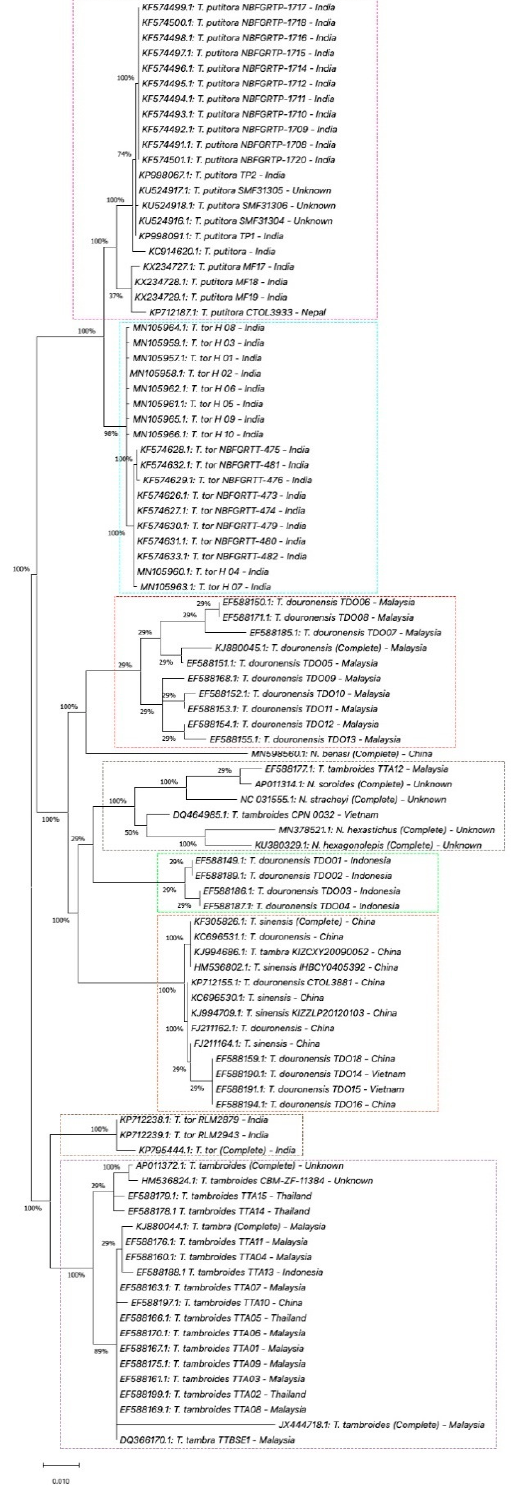
Figure 5. Phylogenetic tree of Tor species using the Cyt b gene. The evolutionary history of the listed Tor species was inferred using the maximum likelihood method and Tamura–Nei model [126]. These analyses were conducted using MEGA X (Version 10.1) [114,115]. Percentages on the branches represent bootstrap values.